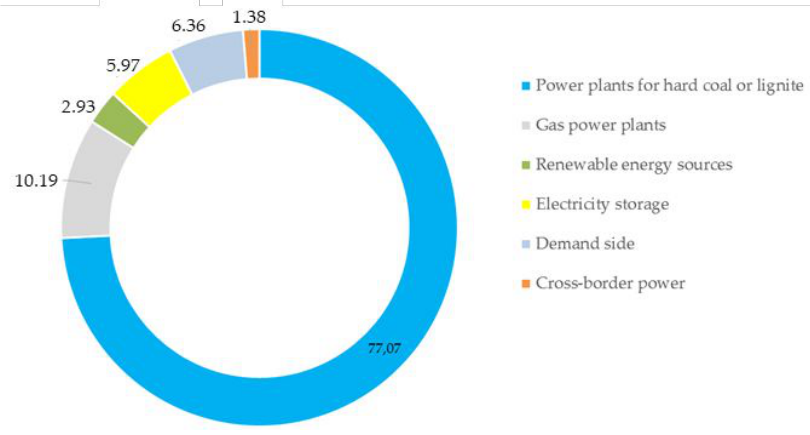
Figure 5. Potential technological mix during the next power